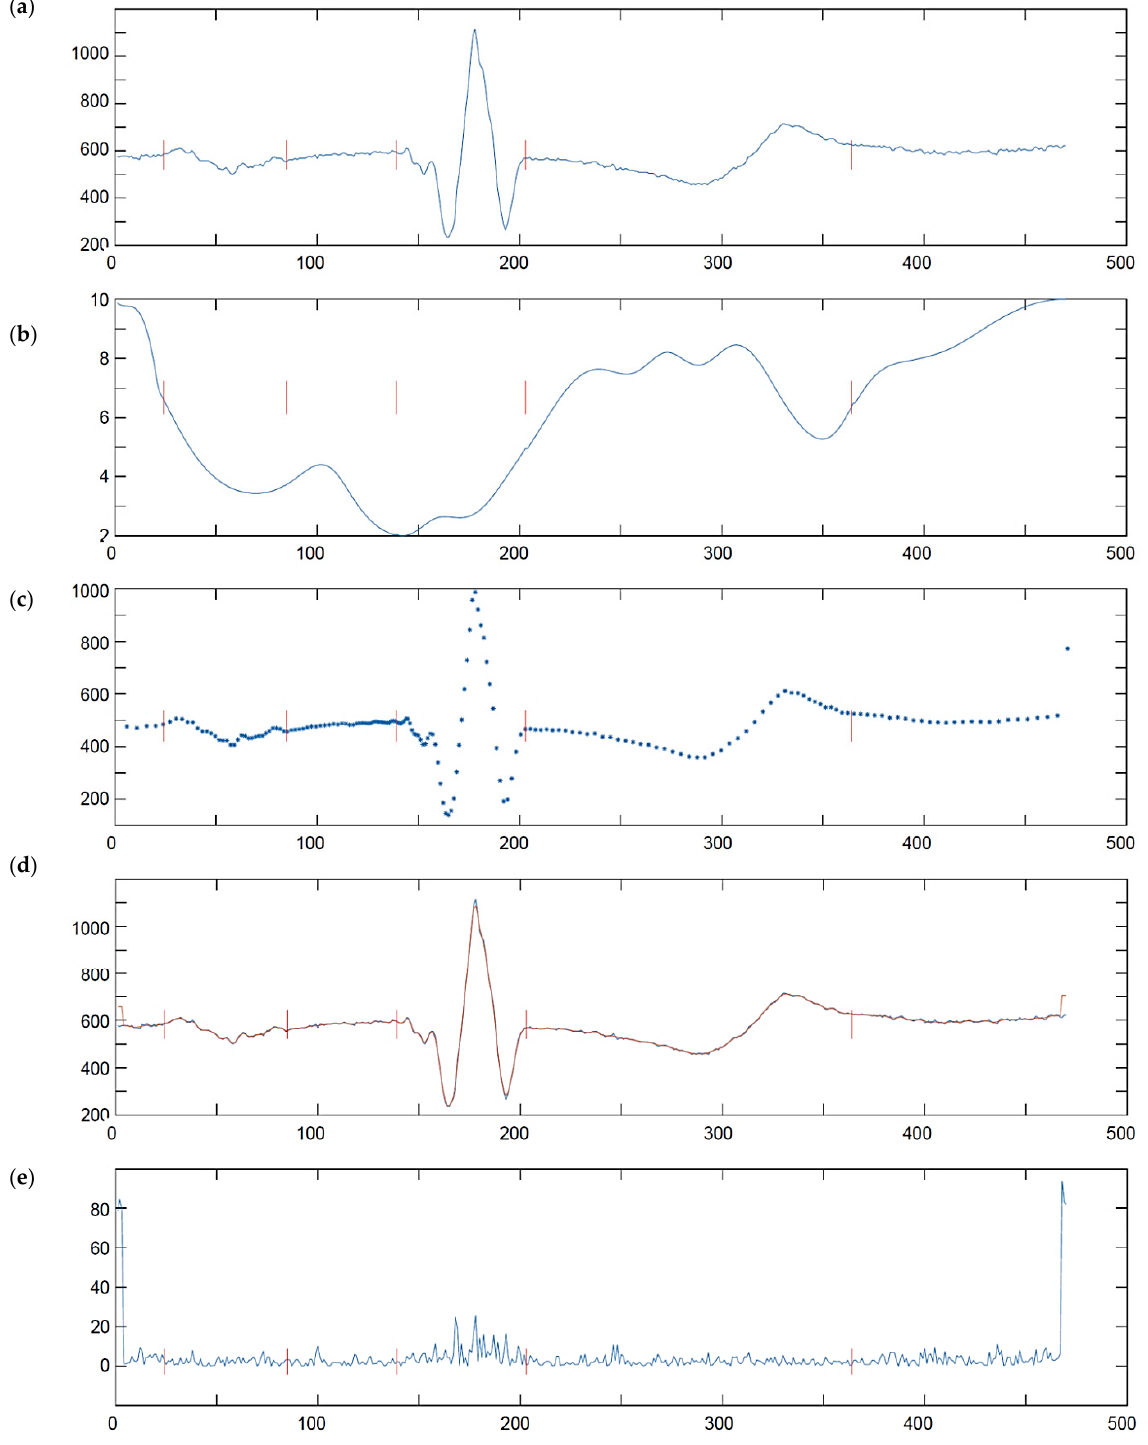
Figure 8. CSE test file MA1_001, lead I ( a ) oECG, ( b ) sampling interval [ms], ( c ) nECG, (dot-plotted to highlight non-uniform sampling), ( d ) uECG (orange) vs. oECG (blue), ( e ) absolute uniformization error (|oECG-uECG|); all horizontal axes in sample numbers (a 2 ms unit); vertical red lines are P, QRS and T-waves delimitation points; errors at both ends of nECG and uECG are caused by adaptive anti-aliasing filter.